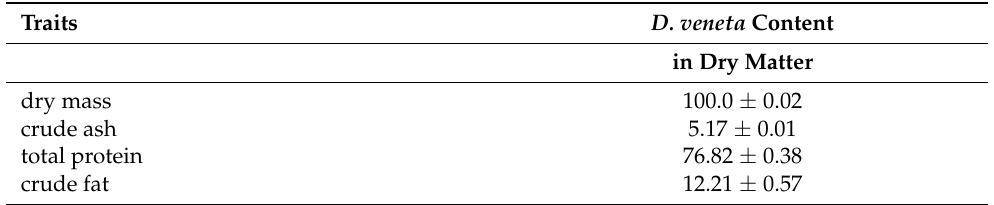
Table 1. Chemical composition (%) of D. veneta cultivated in kitchen waste. Traits